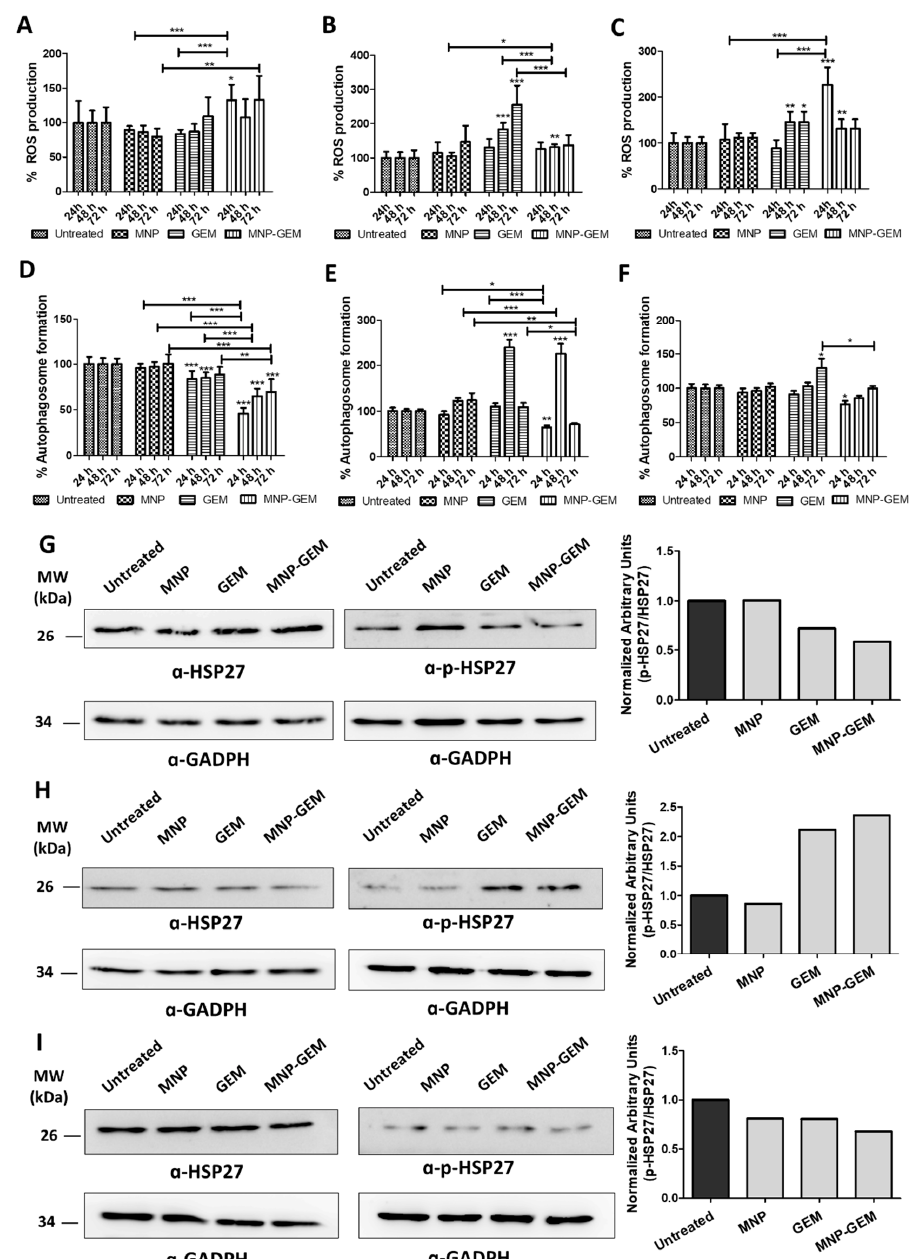
Figure 5. ( A – C ) Quantification of ROS levels by the detection of oxidized DCF-DA 24, 48, and 72 h after treatment; ( D – F ) Quantification of autophagosome formation by measuring the fluorescence of MDC 24, 48, and 72 h after treatment. Data of: ( A , D ) PANC-1; ( B , E ) BxPC-3; ( C , F ) MIA Paca-2. Conditions in PANC-1: MNP 0.5 mg Fe/mL, GEM 22.5 µ M and MNP-GEM 0.5 mg Fe/mL 22.5 μ M. Conditions in BxPC-3 and MIA Paca-2: MNP 0.1 mg Fe/mL, GEM 4.5 μ M and MNP-GEM 0.1 mg Fe/mL 4.5 μ M. Data represent mean ± SD. Statistical analysis was performed using one-way ANOVA test (each group vs. control). * p < 0.05, ** p < 0.001, *** p < 0.001. ( G – I ) Analysis of HSP-27 phosphorylation in PANC-1, BxPC-3, and MIA Paca-2, respectively. Densitometry analysis plots show arbitrary units calculated as a p-HSP-27 signal normalized to a HSP-27 signal. Before p-HSP-27/HSP-27 normalization, p-HSP-27 or HSP-27 signal was normalized to the GADPH